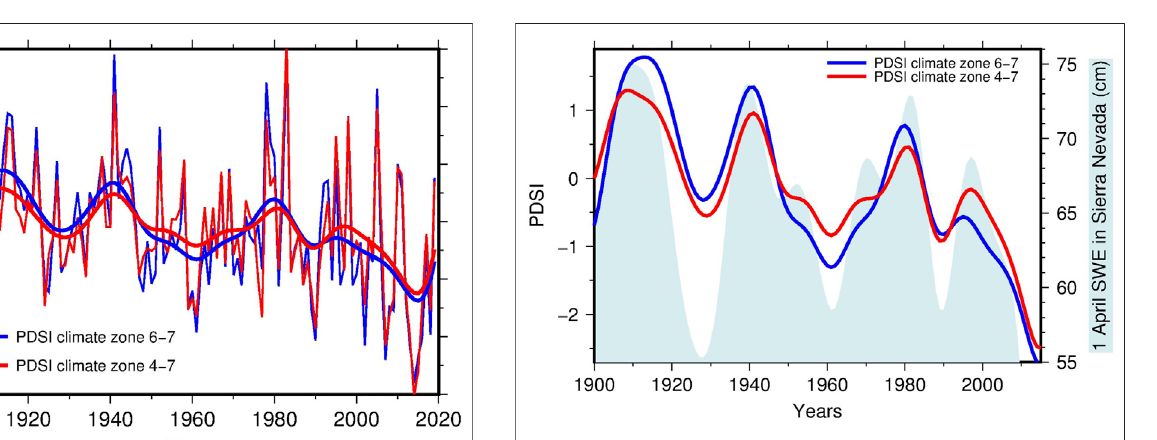
FIGURE 4 | PDSI averaged over the climate zones 6 – 7 (blue line) and 4 – 7 (red line) compared with the trend of the 1 April Snow Water Equivalent (SWE) in Sierra Nevada (light blue area). All the curves were smoothed by Gaussian kernel smoothing with bandwidth parameter h (cid:1) 4